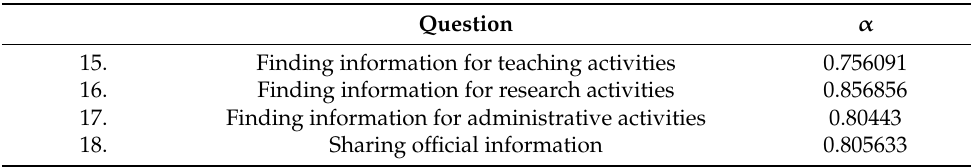
Table 3. Cronbach’s alpha